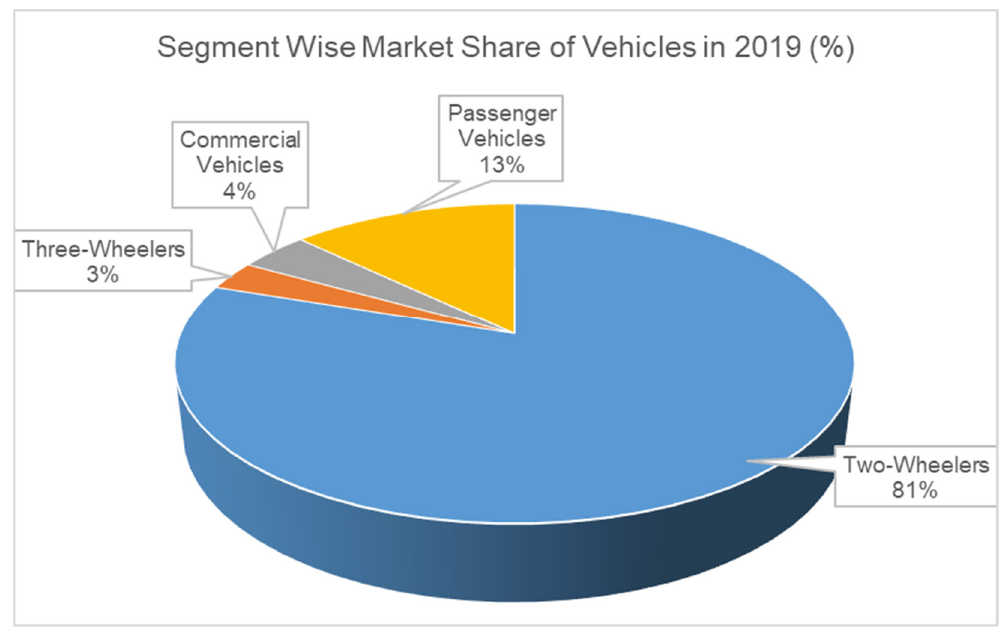
Figure 3. Segment Wise Market Share of Vehicles in 2019.